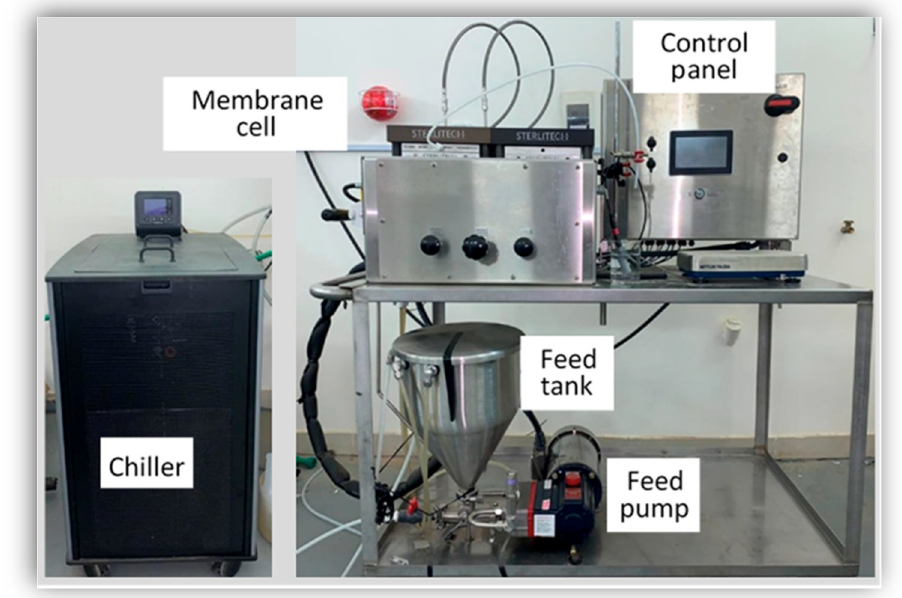
Figure 1. SEPA Cross-Flow Membrane Rig.